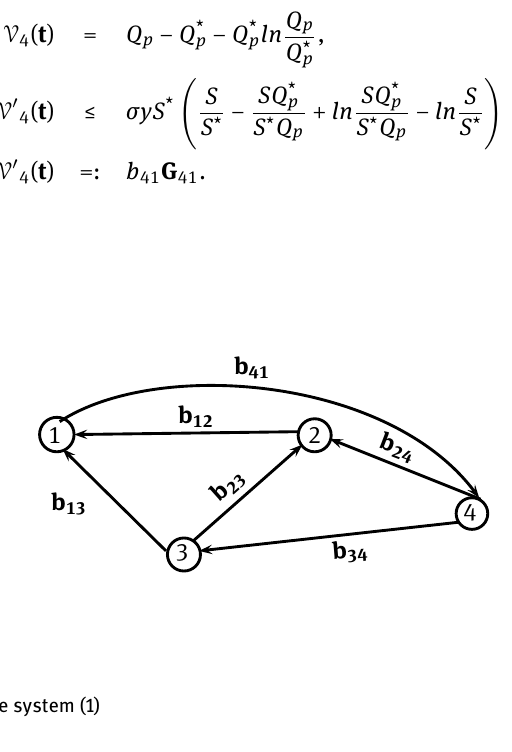
The edge weighted-digraph contains four vertices: V = connected with three cycles. Moreover, G 41 + G 34 + G 23 + G 12 = 0, G 24 + G 12 + G 41 = 0 and G 41 + G 34 + G 13 = 0 along